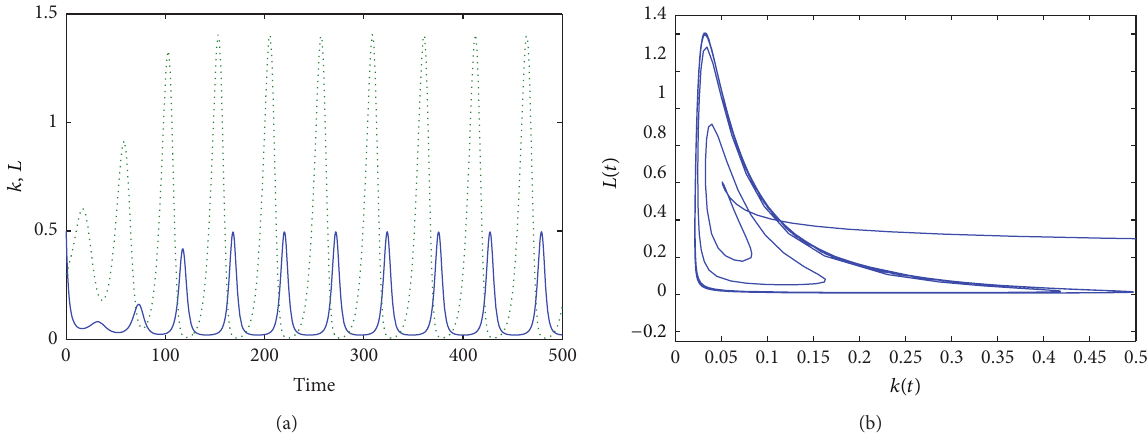
Figure 2: The time evolution of the functions 𝑘(𝑡) (dotted line) and 𝐿(𝑡) for 𝛼 = 0.8 , 𝑠 = 0.5 , 𝑎 = 0.2 , 𝑏 = 0.5 , 𝛿 = 0.9 , and 𝜏 = 11 (a).